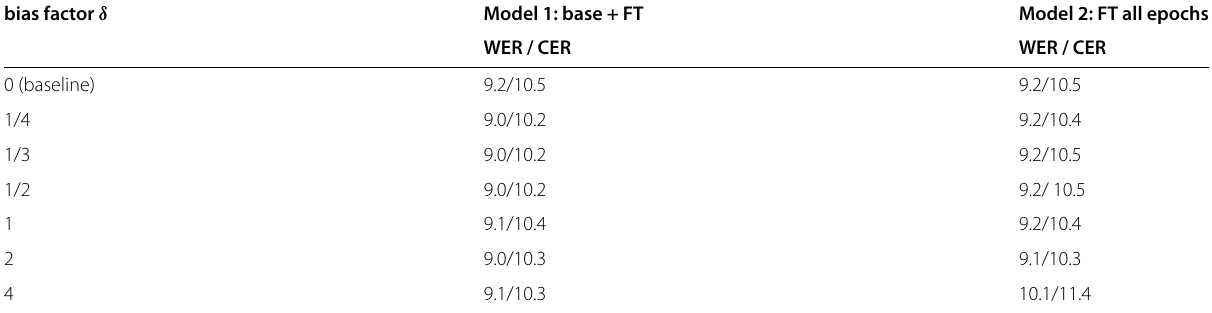
Table 4 A comparison of using different bias factor. WERs and CERs are in percent and evaluated on the manually segmented dev